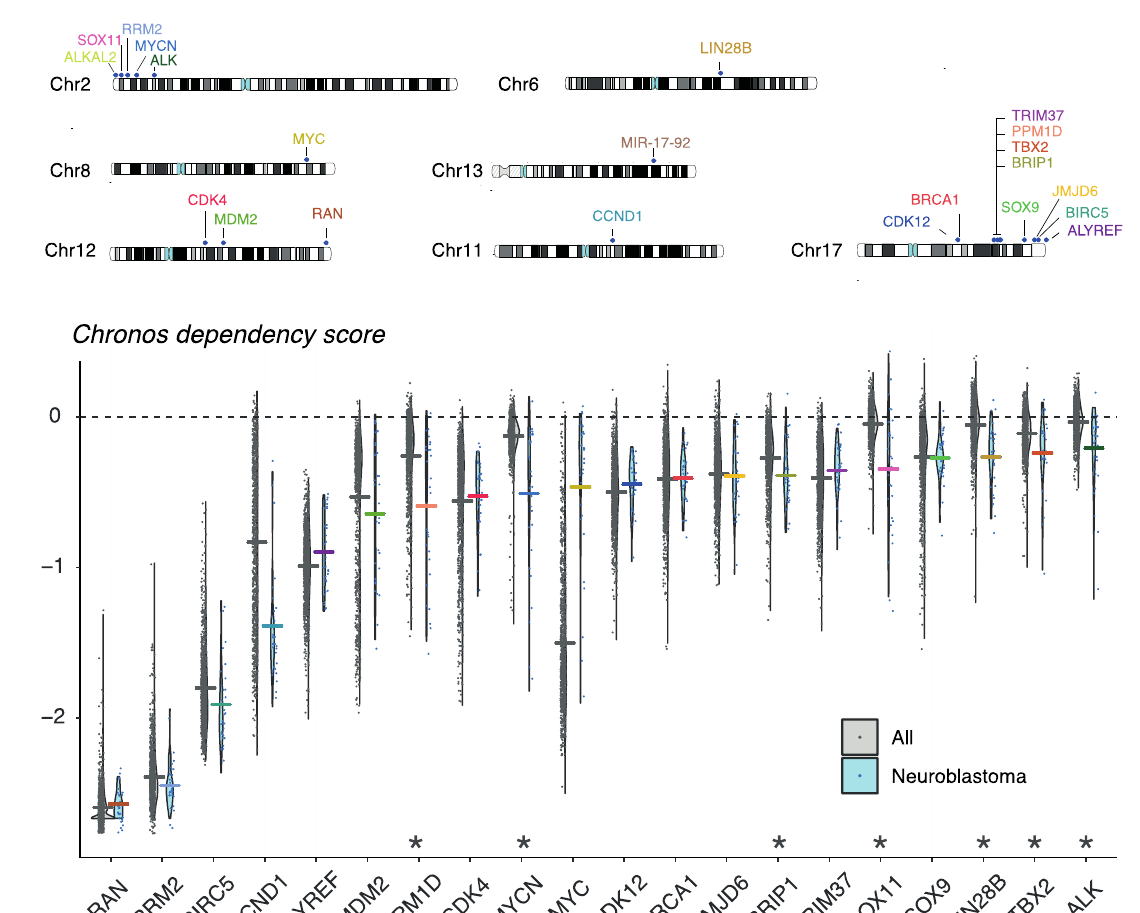
Figure 4. Copy number affected genes in NB that were discussed in this review are depicted on their chromosome (chromosome 2, 6, 8, 11, 12, 13 and 17). Chronos dependency score for each copy number affected gene discussed in this review in a publicly available CRISPR screen across 1032 cancer cell lines (AVANA CRISPR 21Q3, available via the DepMap Portal). A lower Chronos score indicates a higher likelihood that the gene is essential for the cell line. Asterix means that the mean dependency score of the gene in NB cells (blue) is significantly lower than the mean dependency score in other cell lines (grey). Two-group comparison with p -value for each gene computed from empirical Bayes moderated t-statistic, enriched lineages are those with p -value < 0.0005. Dependency scores for ALKAL2 and MIR-17-92 are not available.